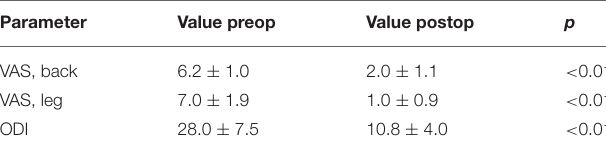
TABLE 2 | Clinical outcomes. Parameter Value preop Value postop